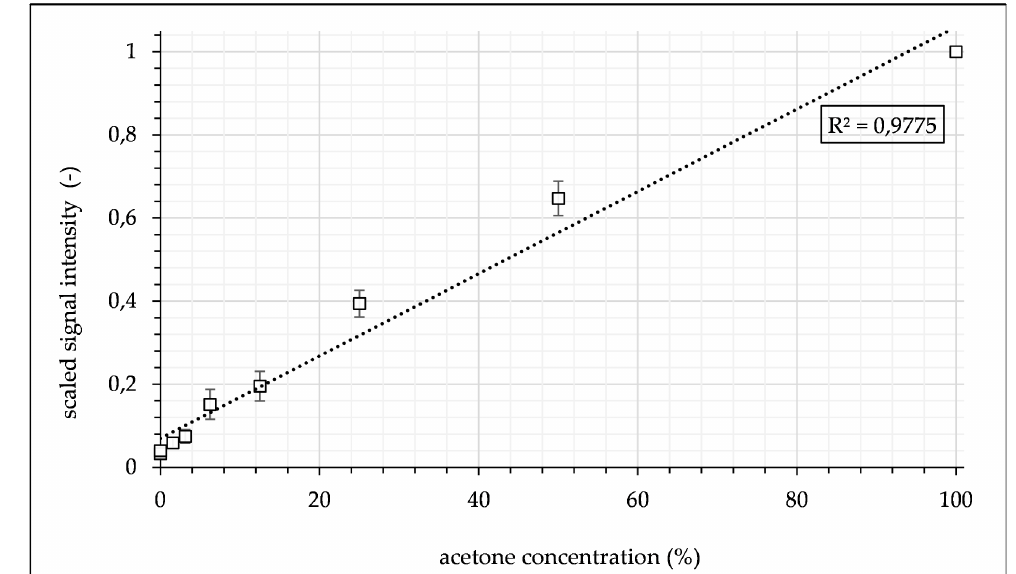
Figure 7. Calibration data of acetone signal intensity as a function of concentration measured during flow inside the microchannel. Data are scaled to maximum acetone intensity for comparability of different data sets.